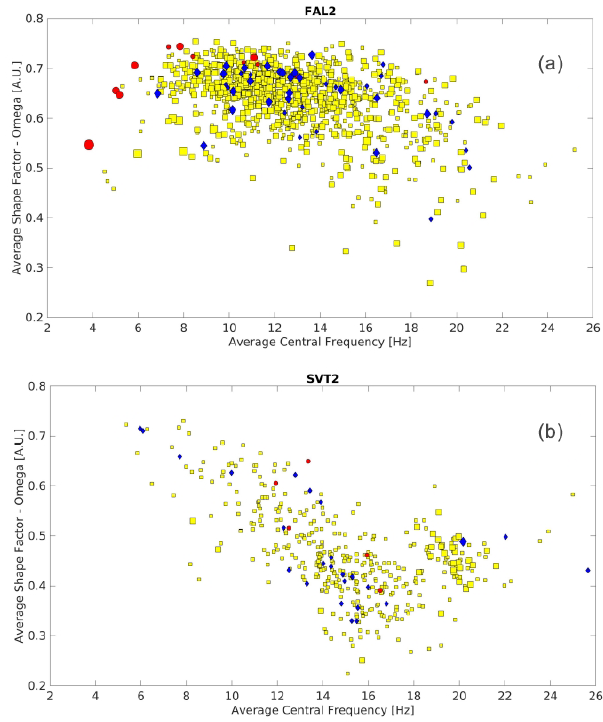
Figure 6. Average shape factor vs central frequency evaluated for FAL2 (a) and SVT2 (b) stations located in the most densely popu- lated sites. LF events, unclassified events and VT events are shown with red circles, blue diamonds and yellow squares respectively. The symbol size represents the maximum amplitude of the observed signals. The presented results are obtained by averaging on the three components of motion.